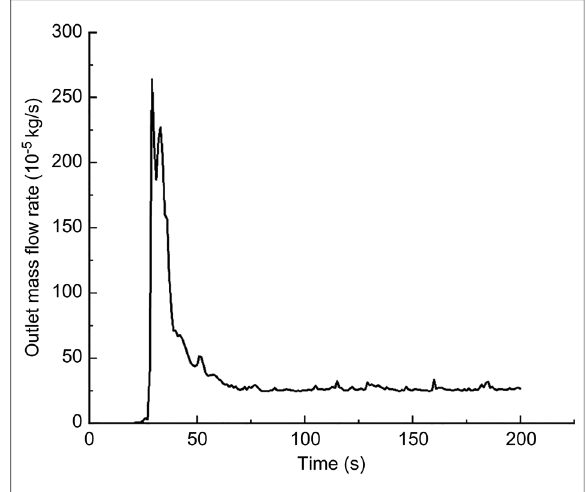
FIGURE 13 The outlet mass fl ow rate monitoring graph of the straight model of the curved plus extended groove incision.